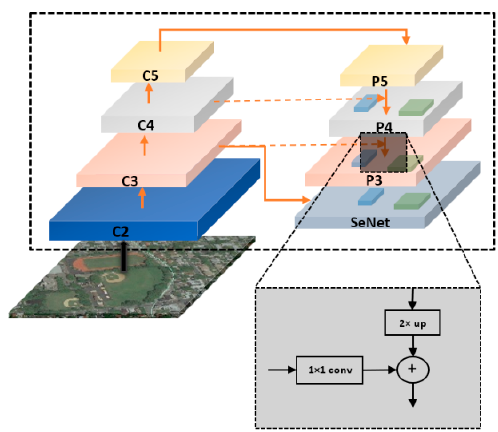
Figure 5. Lateral connection architecture and the way of merging the layers by the addition operation.